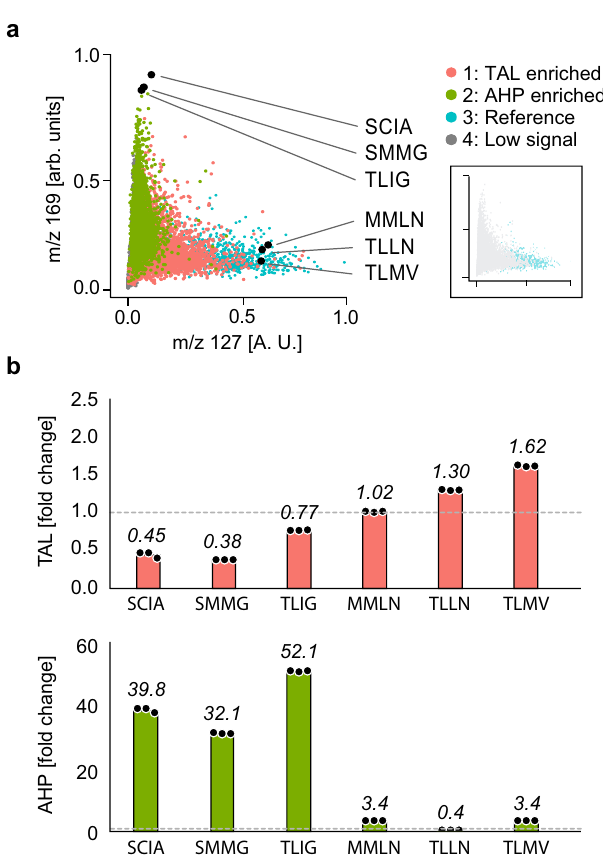
Fig. 4 µ MS screen of g2ps1 mutant library for increased production of TAL or AHP. a Normalized m / z intensity for m / z 127 (TAL) versus 169 (AHP). Data points are colored based on clusters identi fi ed from UMAP analysis in Fig. 2. Inset shows reference strain samples. The highest producers for TAL and AHP were isolated, sequenced, and con fi rmed in bulk analysis (black circles). b TAL and AHP for selected bulk cultures as fold change over wild type (TLML). n = 3 independent experiments. Bar plots represent mean values, with black dots representing each measurement of the samples. Source data are provided as Source Data and raw data in Supplementary Data 5 and